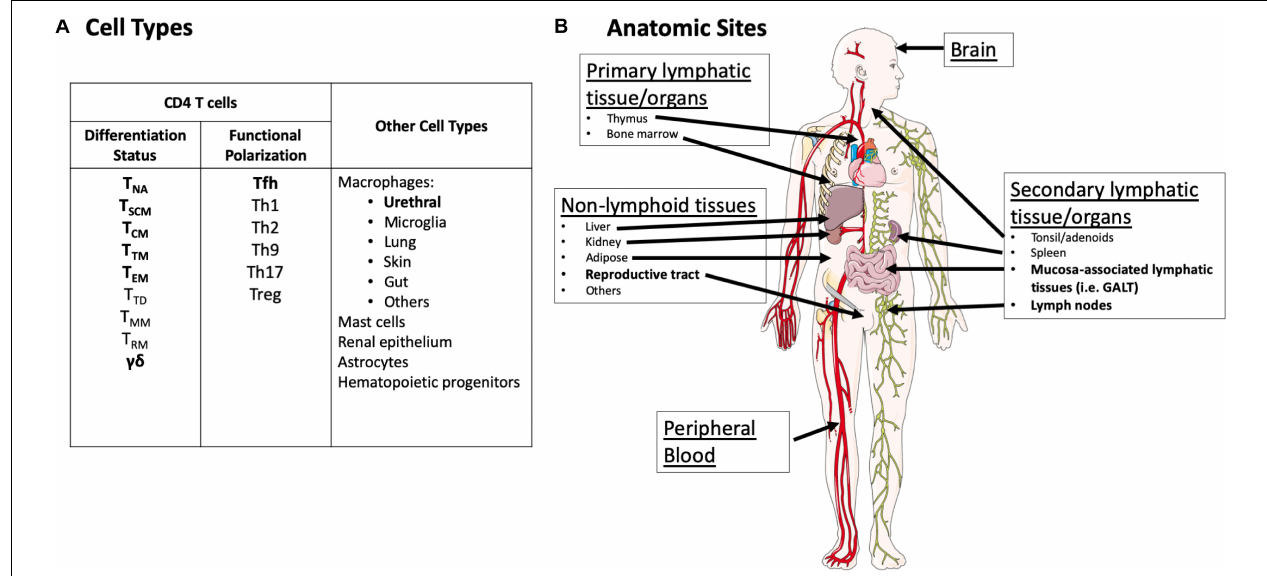
FIGURE 1 | Overview of cell types and anatomic sites reported to harbor the latent reservoir. (A) Cell types thought to harbor the HIV reservoir. Cell types with demonstrated recovery of replication-competent virus (defined as propagating virus in an outgrowth assay) in humans following years of suppressive ART are in bold. Cell types in regular font represent cells where HIV nucleic acid has been detected by PCR and/or sequencing either in humans or animal models but recovery of replication-competent virus in humans after years of suppressive ART has not been demonstrated. It is important to note that for many cell types, there has been very sparse sampling for replication-competent virus. NA, naïve; SCM, stem cell memory; CM, central memory; TM, transitional memory; EM, effector memory; TD, terminally differentiated; MM, migratory memory; RM, resident memory. (B) Anatomic sites with demonstrated recovery of replication-competent virus in humans following years of suppressive ART are highlighted in bold. Potential replication-competent anatomic reservoir sites are in regular font. These sites represent tissues/organs where HIV nucleic acid has been detected either in humans or animal models but recovery of replication-competent virus in humans after years of suppressive ART has not been demonstrated. It is important to note that for many tissue types, there has been very sparse sampling for replication-competent virus. Images were derived and modified from Servier Medical Arts under a Creative Commons Attribution 3.0 Unported